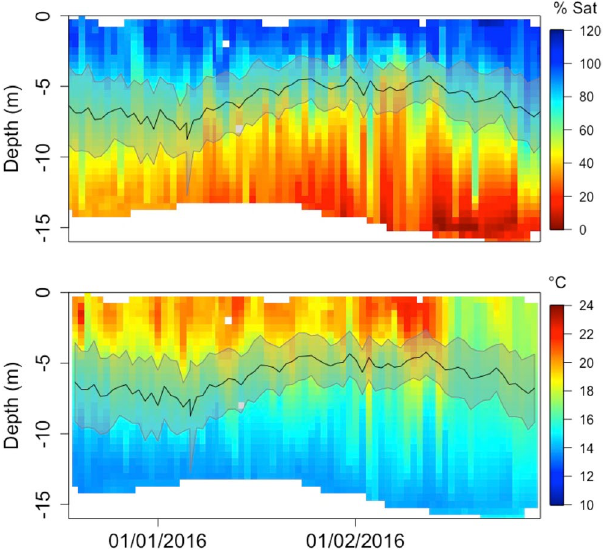
Figure 2. Profile of DO and temperature in experimental cage 1 during the study period. Black line indicates mean swimming depth averaged over all tagged fish in cage 1. Grey area shows ± 1 SD.